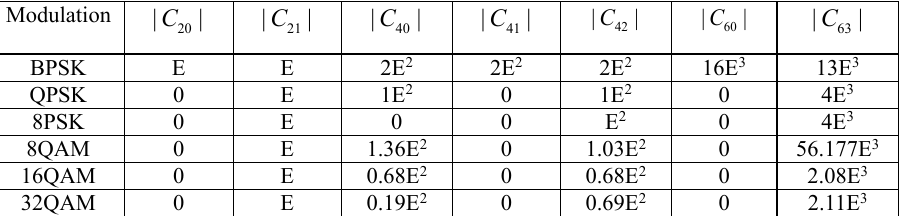
Table1. Higher-order cumulant theoretical value of the